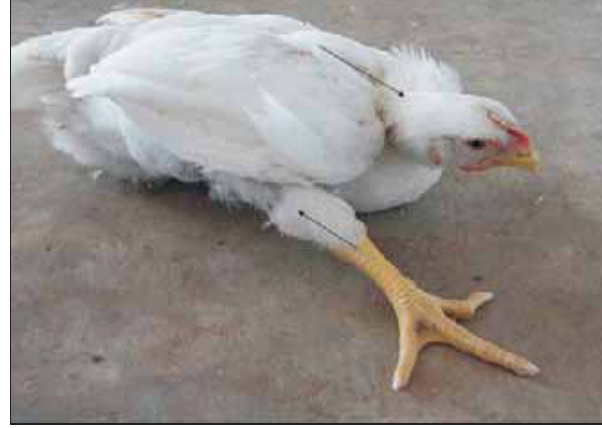
Figure-2: Rotation of tibio-tarsal joint in high energy fed